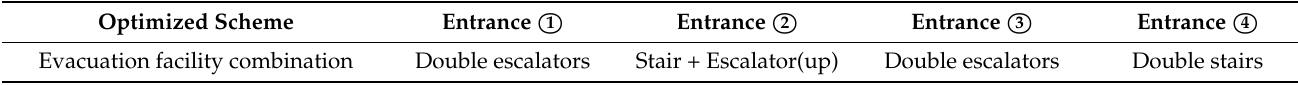
Table 3. Combination form of optimized evacuation facilities. Figure 3. Layout schematic diagrams of station hall floor before and after optimization: ( a ) layout